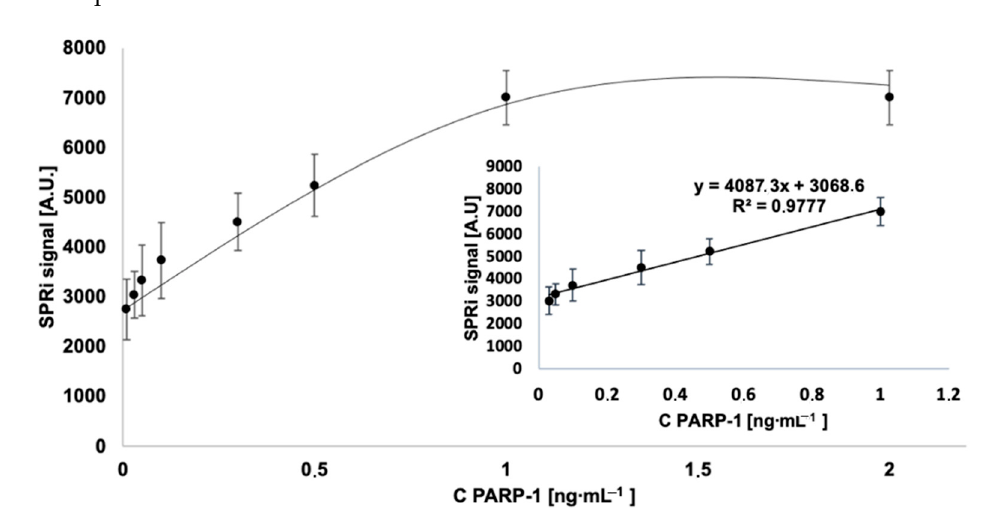
Figure 4. Calibration curves. Concentration of antibody = 2 ng · mL − 1 , pH = 7.4.